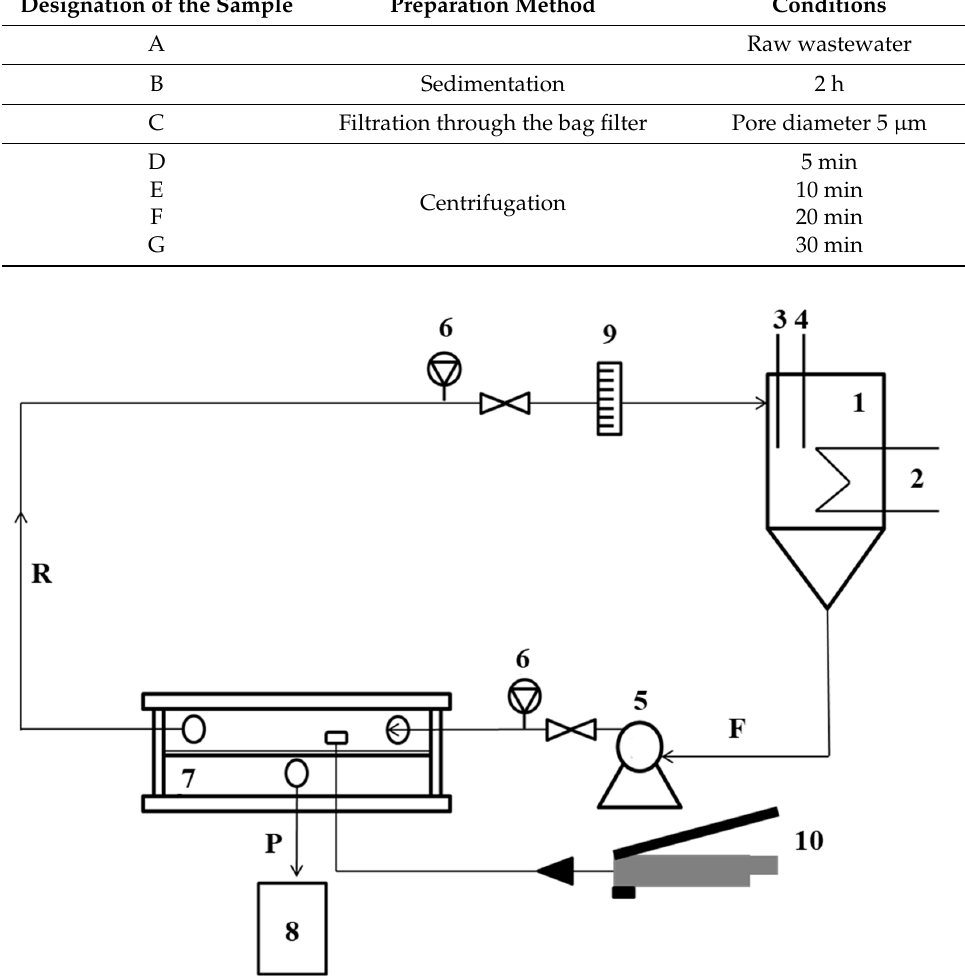
Figure 3. Diagram of a laboratory membrane filtration system: 1—feed tank; 2—thermostat; 3—